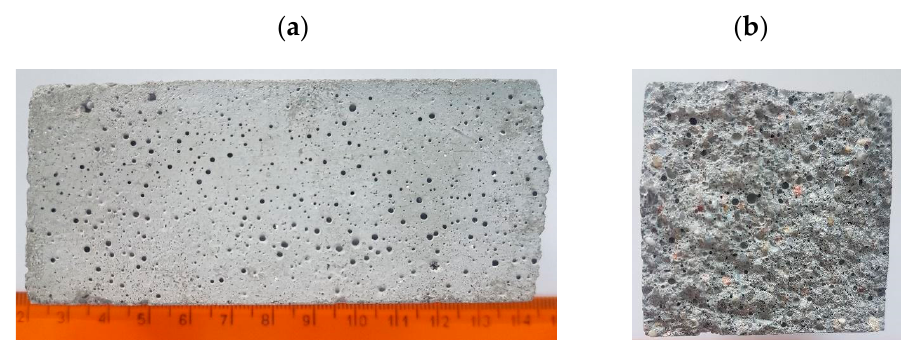
Figure 8. Cement mortar modified with the addition of 4% fly ash modified with nanosilica: ( a ) outer surface; ( b ) internal structural view.